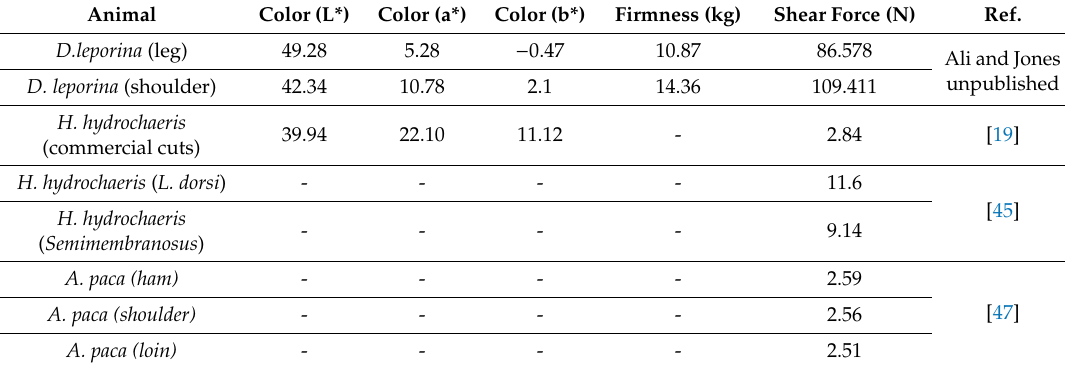
Table 3. Physical parameters for selected neo-tropical rodent